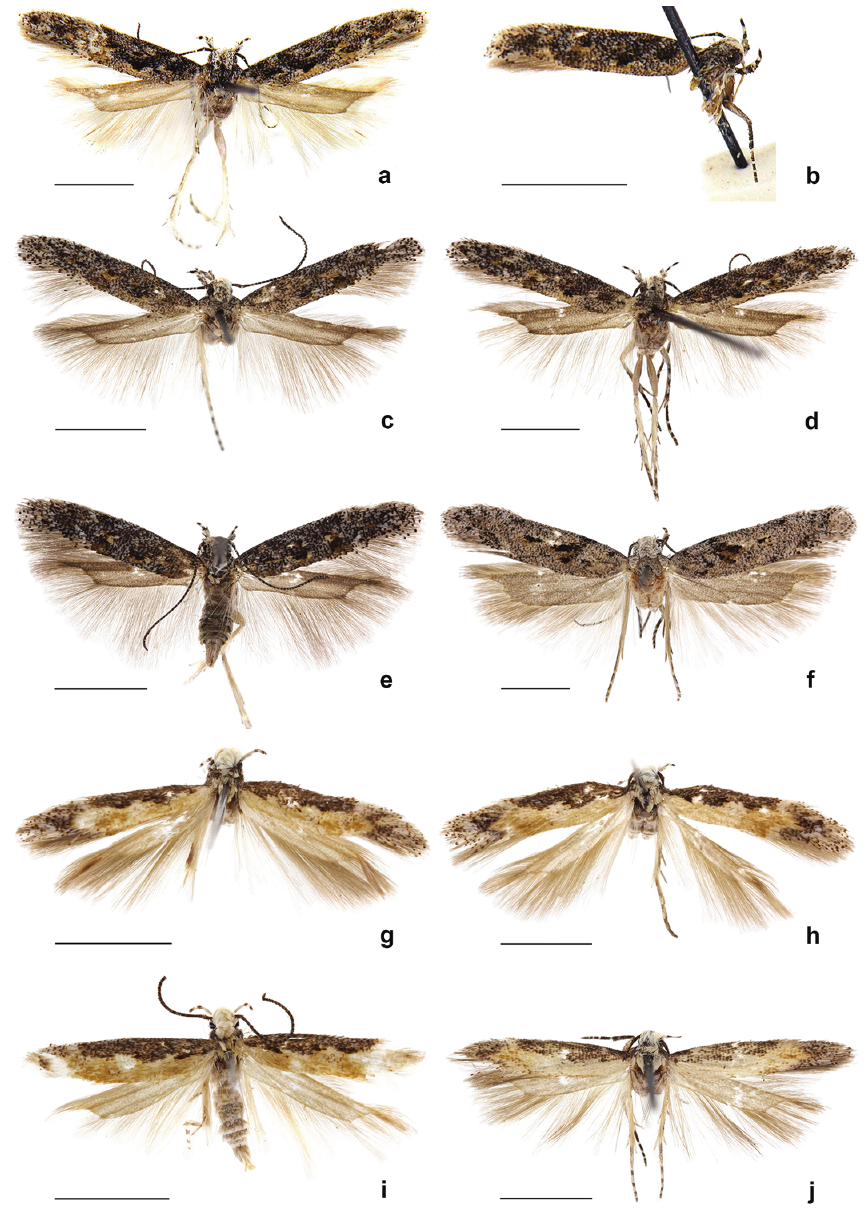
Figure 1. Adults of Neopalpa species. a–f N. neonata g–j N. donaldtrumpi sp. n. N. neonata : a holotype ♂ EMEC82306 (CA: Santa Catalina Island) b paratype ♂ EMEC342305 (Mexico: Baja California Sur) c ♀ CNCLEP00077350 (CA: Santa Cruz Island) d ♀ EMEC407544 (CA: Santa Cruz Island) e ♂ LAC- MENT326744 (CA: San Bernardino County) f ♀ EMEC408849 (CA: Modoc County); N. donaldtrumpi sp. n.: g Holotype ♂ UCBMEP0201628 (CA: Imperial County) h Paratype ♀ UCBMEP0201482 (CA: Imperial County) i Paratype ♂ UCBMEP0201629 (CA: Imperial County) j Paratype ♂ EMEC408498 (Mexico: Baja California Sur). For detailed specimen data see Suppl. material 1. Scale bar 2